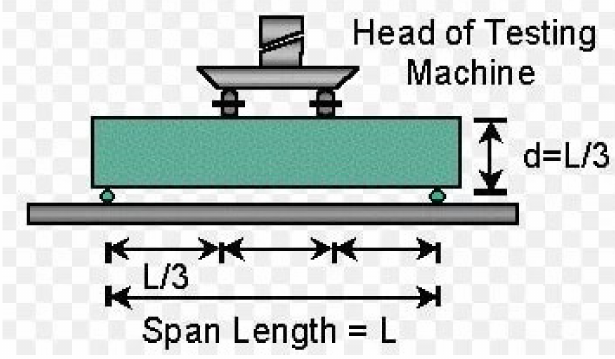
Figure 3. Loading Configuration: Four-Point Load Flexural Test (ASTM